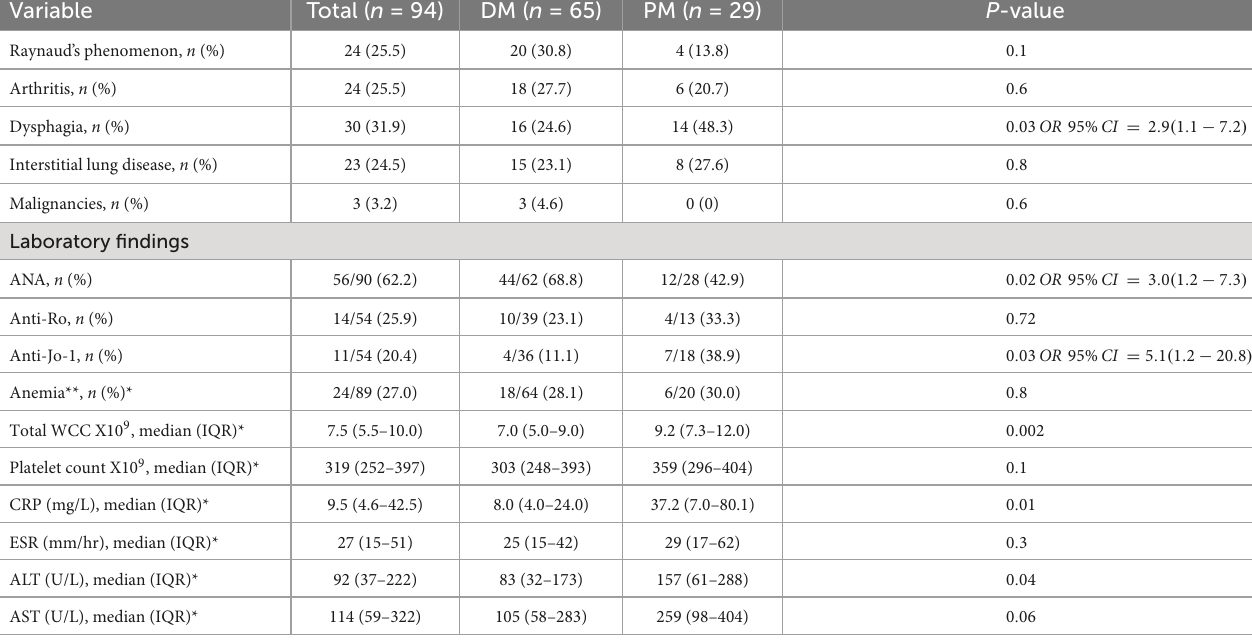
TABLE 2 Other clinical and laboratory features and outcomes in 94 patients with idiopathic inflammatory myopathy.